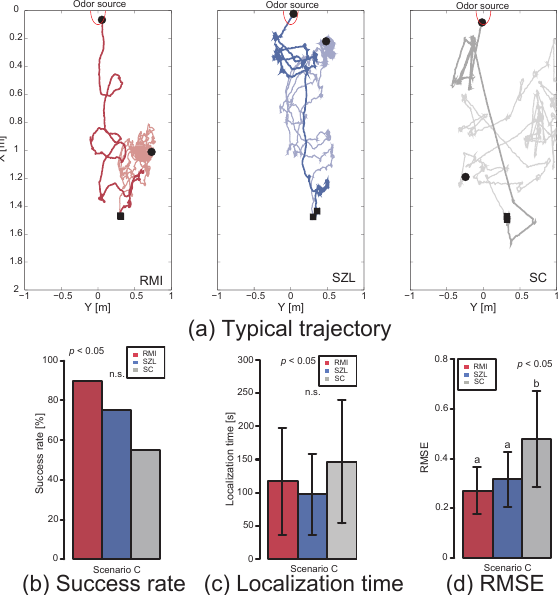
Figure 8. Experimental results for Scenario C. ( a ) Typical trajectory for each algorithm. ( b ) Search success rate. ( c ) Localization time. ( d ) RMSE of trajectory. Groups sharing the same letter are not significantly